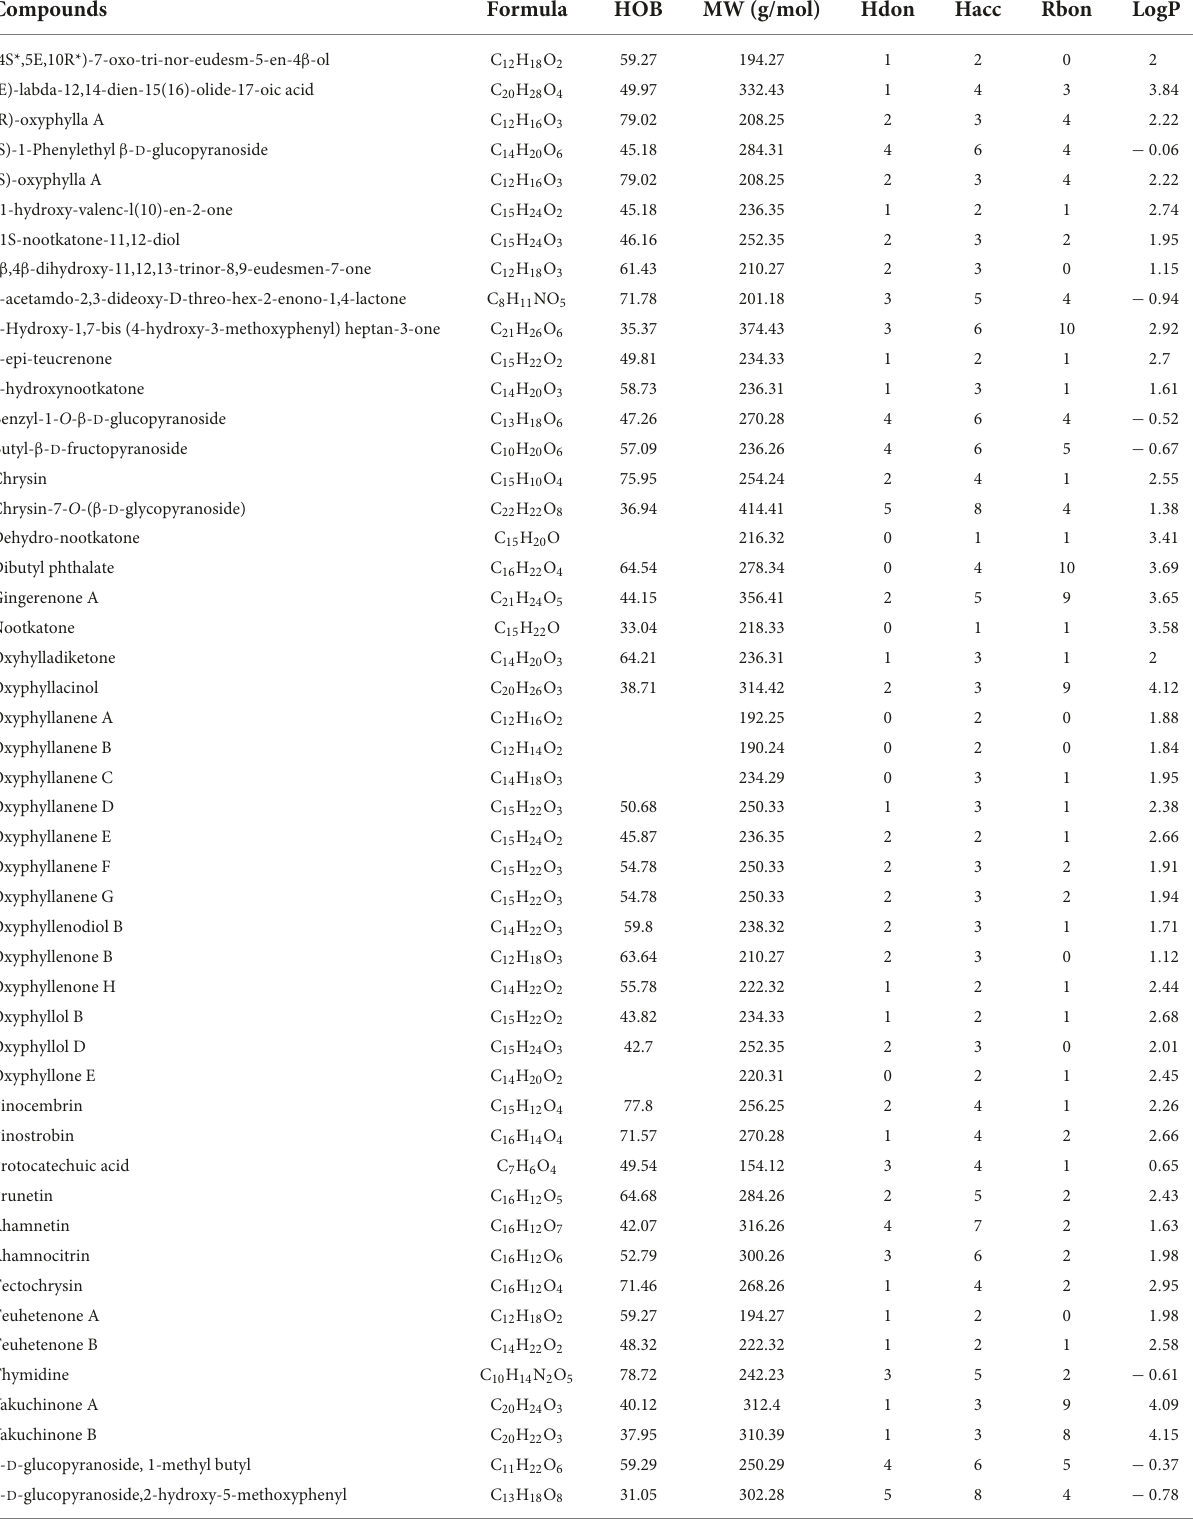
TABLE 1 Pharmacological and molecular properties of the main phytochemicals in AO. Compounds